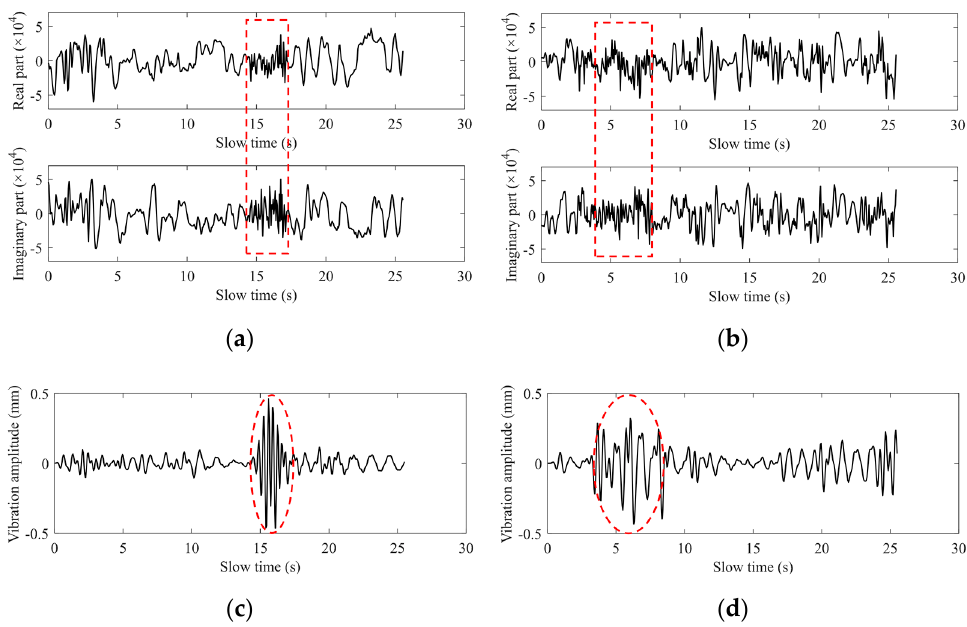
Figure 15. ( a ) The complex data at the selected range bin in a coughing situation; ( b ) The complex data at the selected range bin in the case of arm swinging; ( c ) The heartbeat waveform of coughing scene; ( d ) The heartbeat waveform of arm-swing scene.